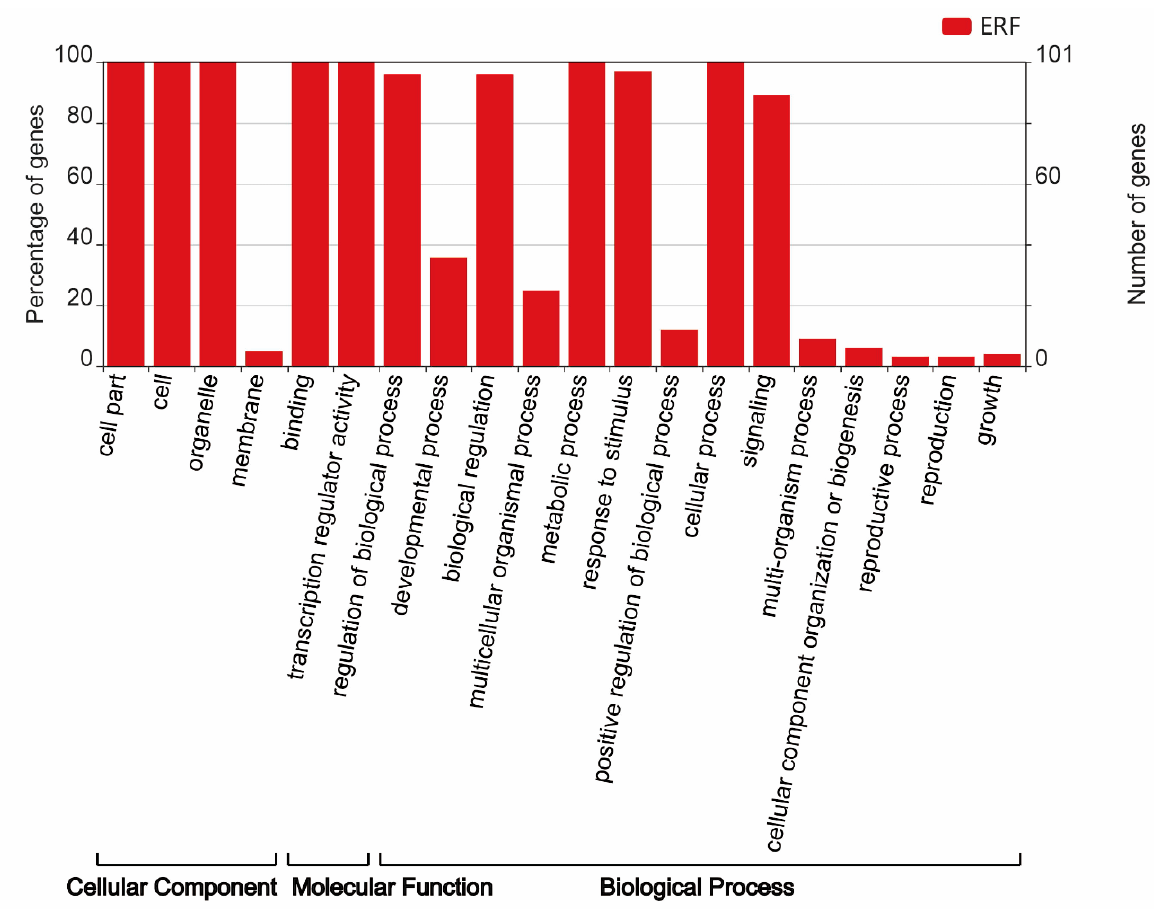
Figure 6. Functional classifications of HpERFs according to the gene ontology (GO) terms assigned to genes.